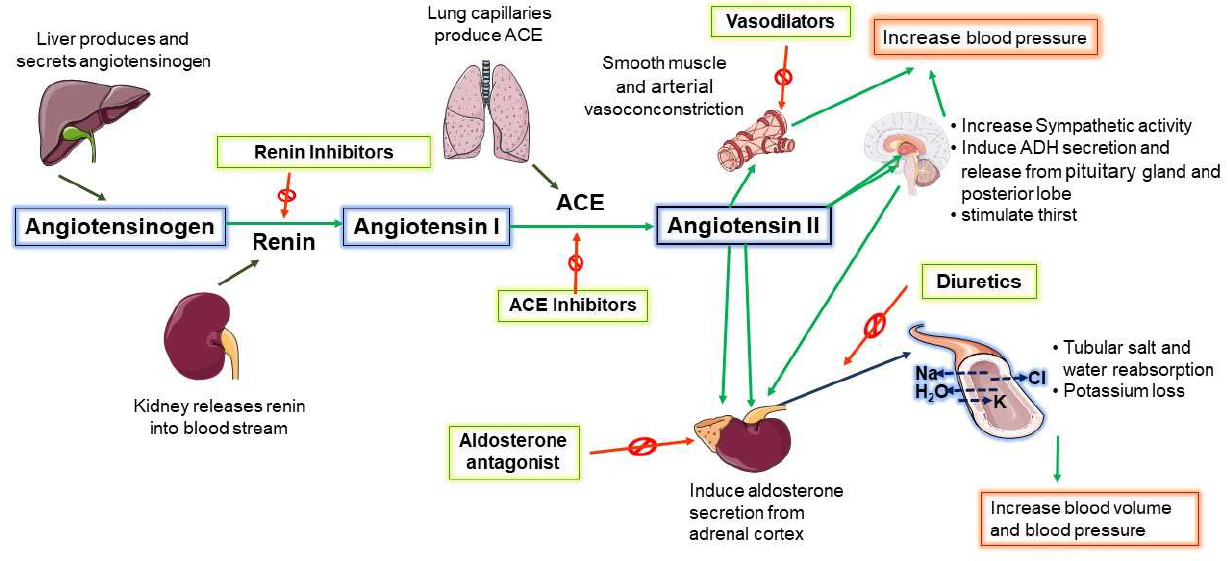
Figure 2. Renin–angiotensin system influence on blood pressure. ACE; Angiotensin Converting